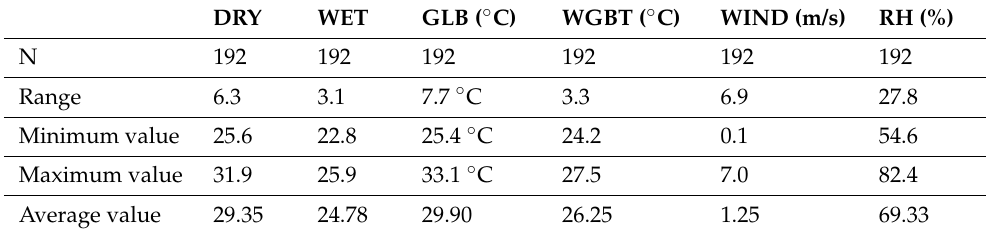
Table 3. Summary of the environmental